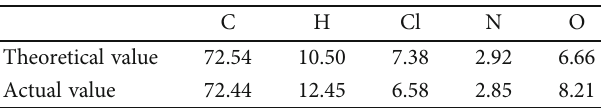
Table 6: Elemental composition of glycine cholesterol ester hydrochloride.